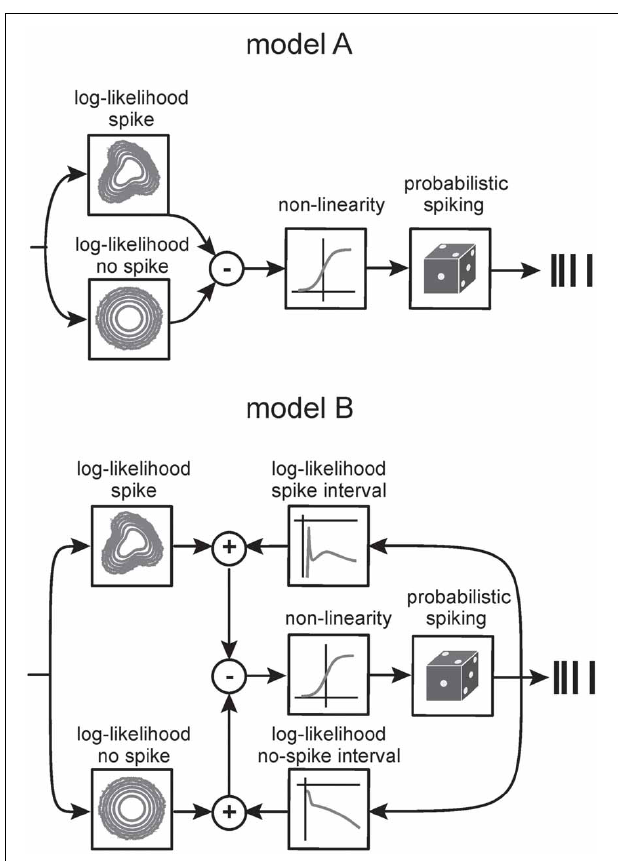
FIGURE 9 | Generative encoding model based on mixtures of Gaussians (STM model). Model A. Non-linear features derived from the fits of spike-triggered and non-spike-triggered distributions by multiple Gaussians (boxes on the left) are linearly combined and the response passed through a sigmoid point non-linearity. The result determines the firing rate of the neuron. Model B. An extension of the model to incorporates spike-time dependencies. Log-densities of observing certain inter-spike intervals are plotted in the top right. The box on the lower right shows the log-density for observing intervals between a bin with no spike and a spike. The four log-likelihood terms are combined in a principled manner to give the firing rate of the neuron. For details of the model, see Theis et al.